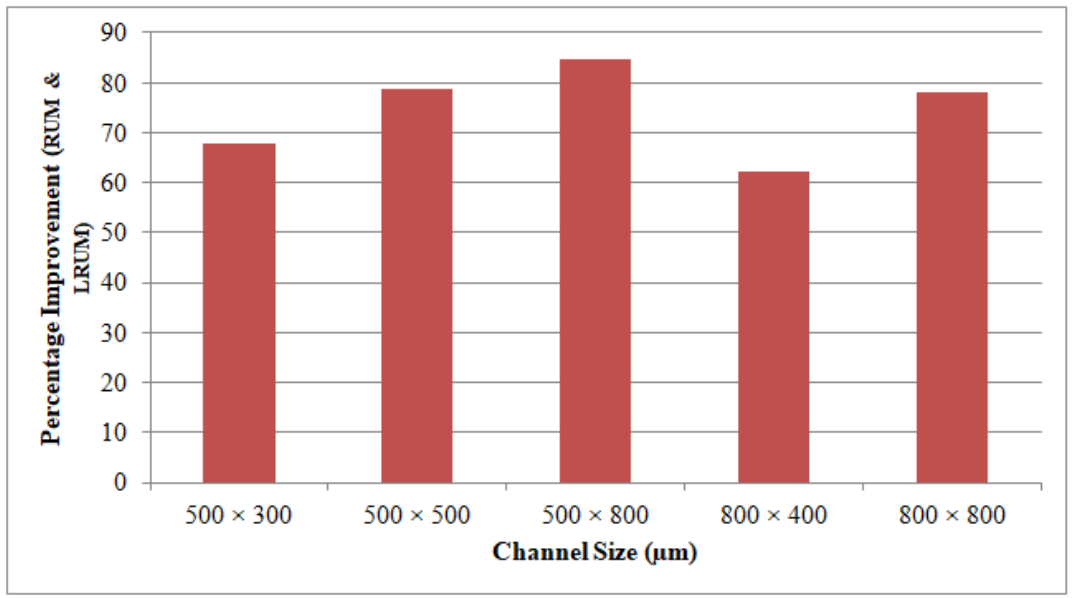
Figure 16. Percentage of improvement in the MT of the fabricated channels by using LRUM comparing to RUM.